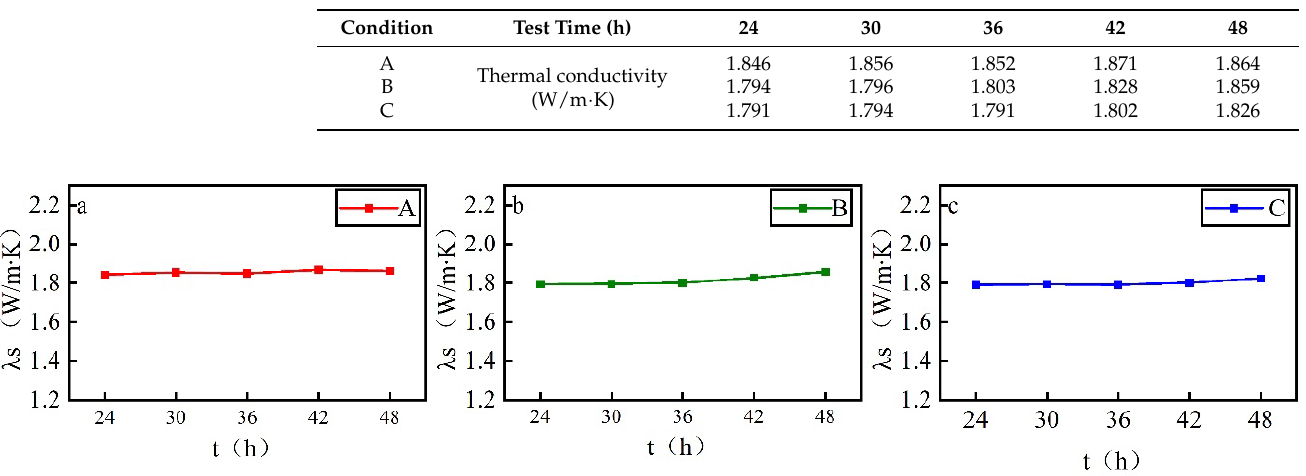
Table 3. Thermal conductivity under the different test times.